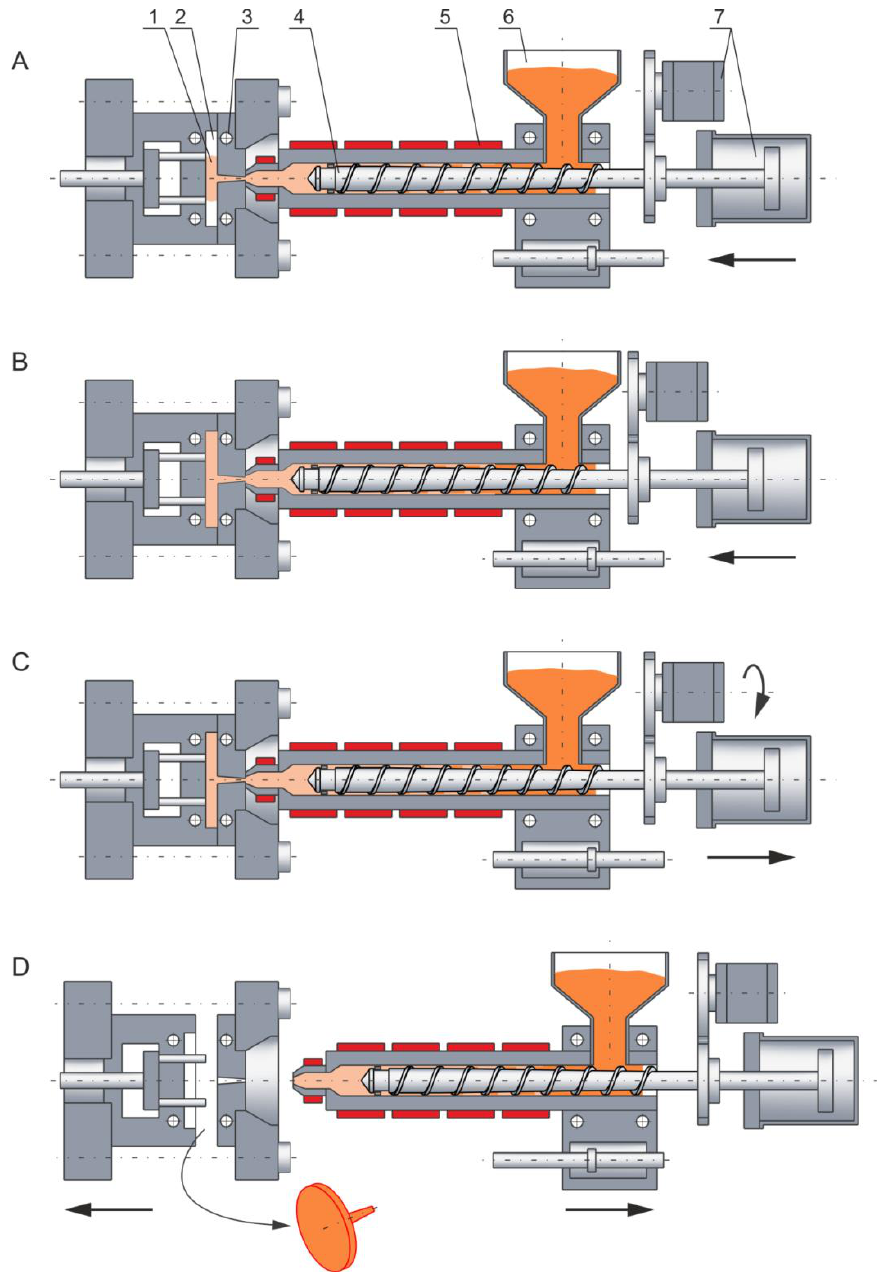
Figure 1. Injection molding process: ( A ) — injection (mold filling), ( B ) — holding, ( C ) — plasticating (melting), ( D ) — mold opening and molding (part) ejection; 1 — molding (part), 2 — mold cavity, 3 — cooling channels, 4 — screw, 5 — heaters, 6 — hopper, 7 — screw drive system (with permission from Rheology in Polymer Processing. Modeling and Simulation by K. Wilczyńsk i ; Carl Hanser Verlag: Munich 2021 [1]).